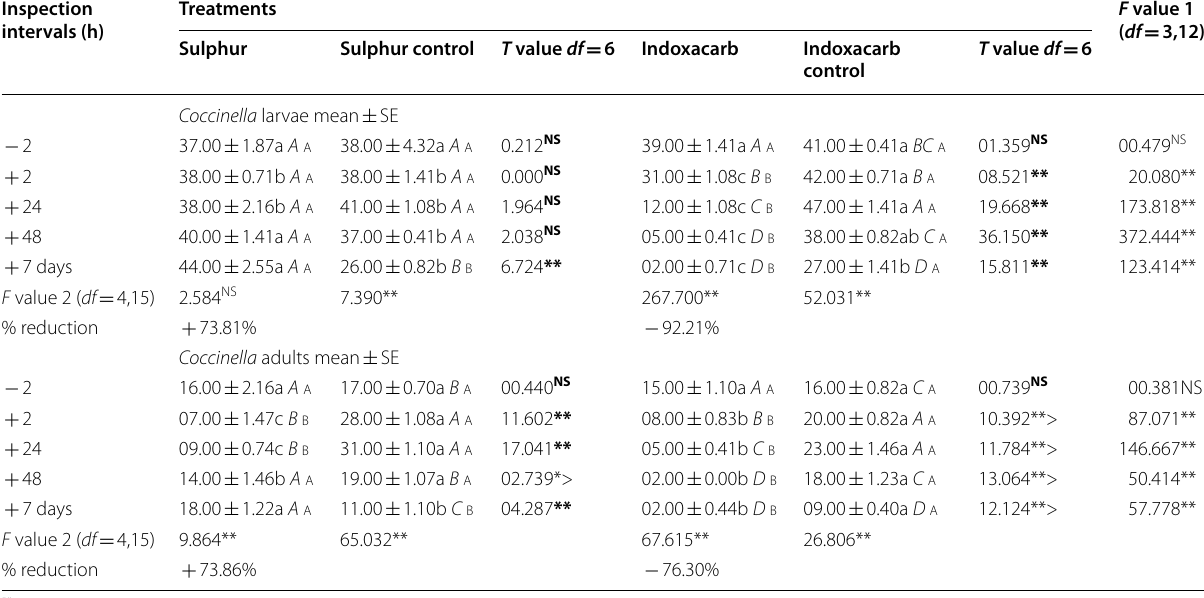
Table 1 Effect of indoxacarb and sorell 98% treatments on the population density of ladybird larvae and